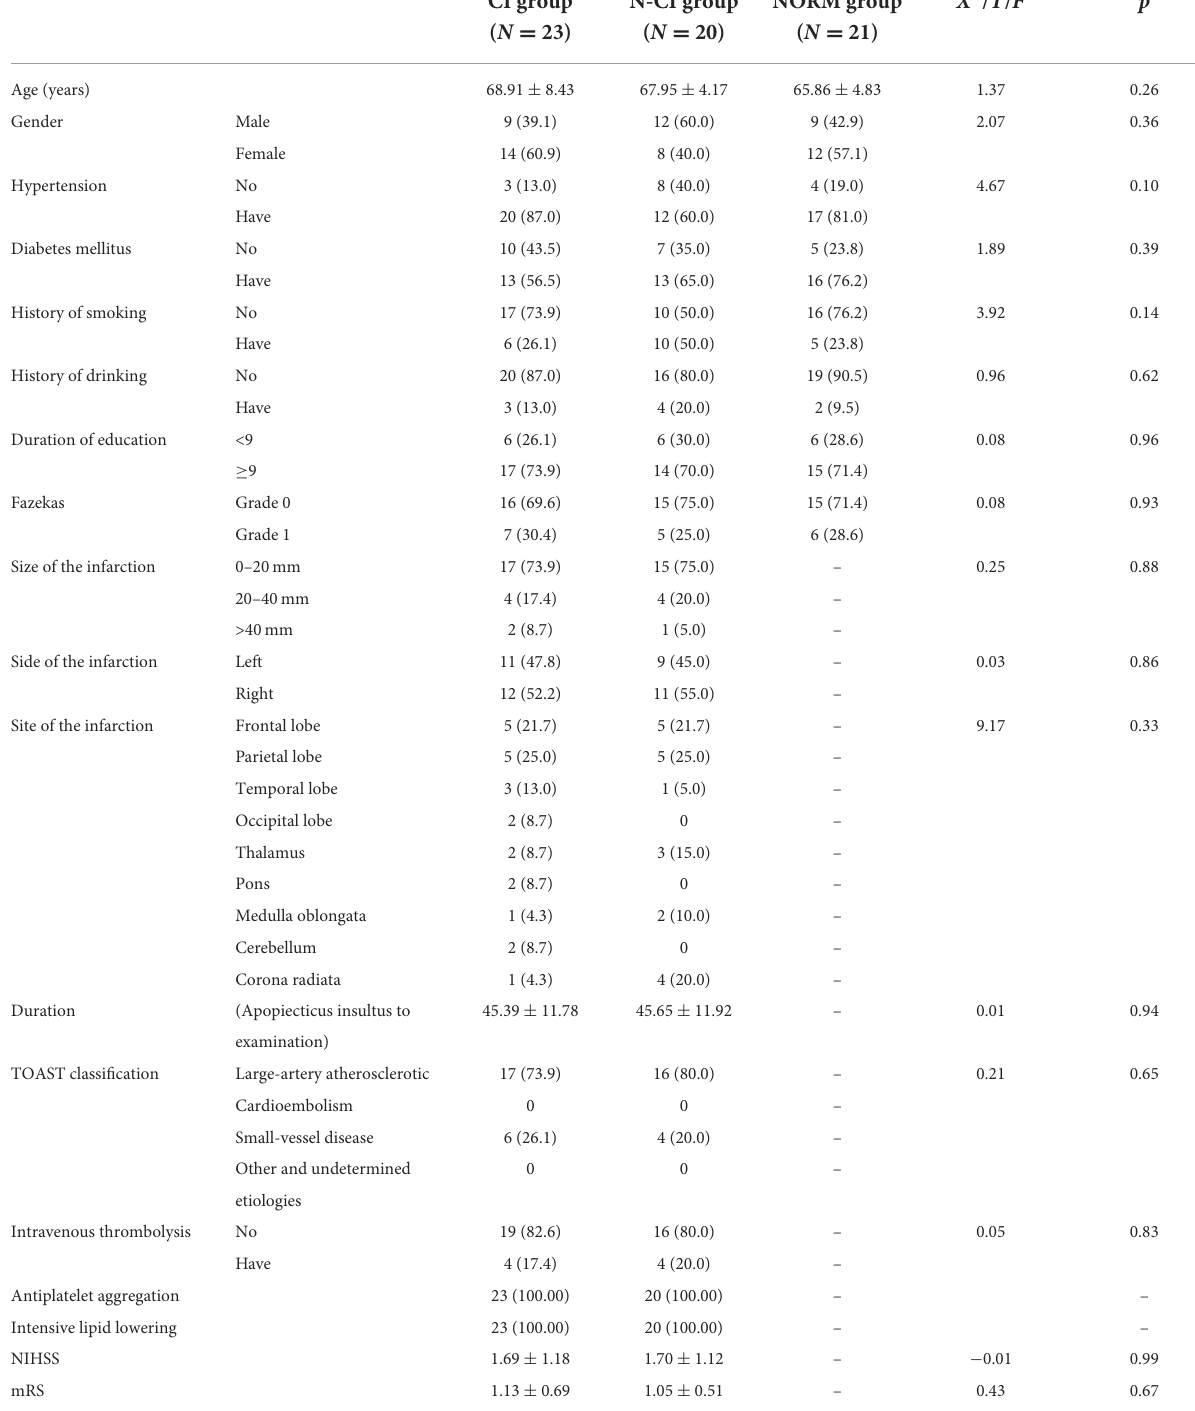
TABLE 1 General characteristics of the study